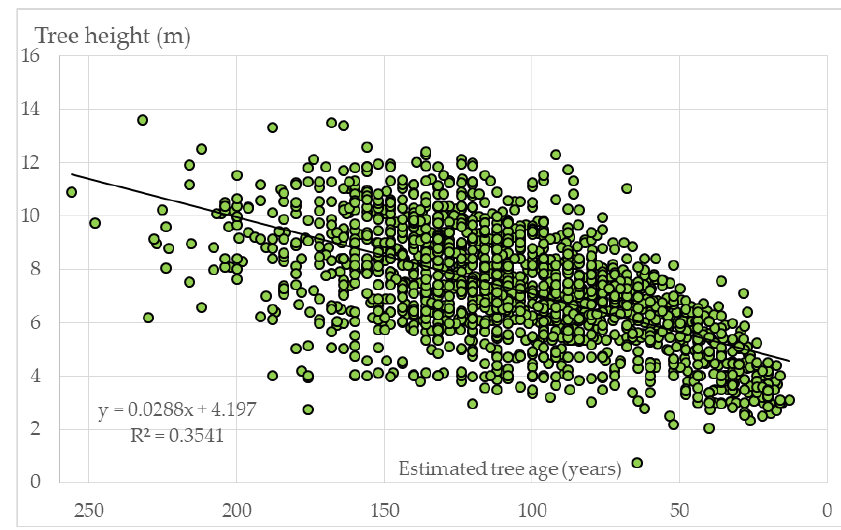
Figure 3. Distribution of age and height of Fukugi trees in Hirae and Maezato. Table 1. Dimensions of Fukugi trees at the survey site.